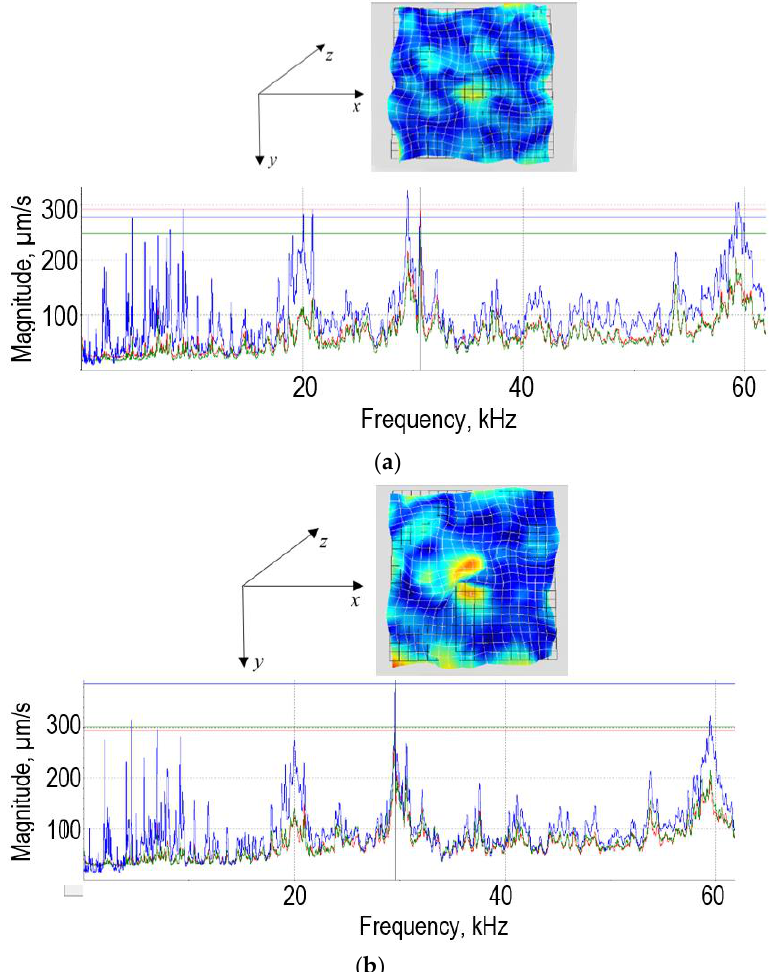
Figure 3. 3D frequency response and deformations of an aluminum alloy sheet in the frequency range from 0.5 to 60 kHz measured with a Polytec PSV-500 3D laser Dopler vibrometer scanner: x (red) and y (green) are lateral vibrations, z (blue) in the normal direction, respectively: influence of tool position and forming depth on the eigenmodes of the sheet at tool position 1, forming depth: ( a ) tool position 1, forming depth 15 mm; ( b ) tool position 2, forming depth 30 mm.